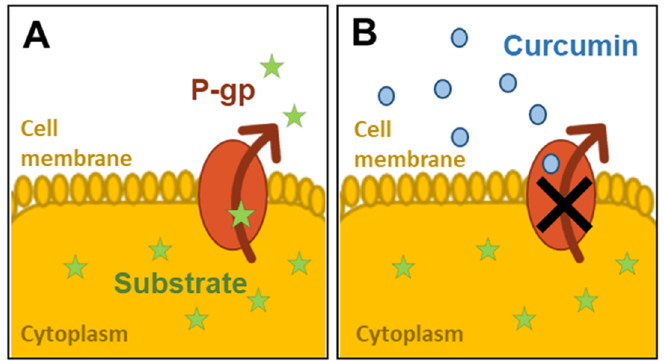
Figure 1. Inhibition of P-glycoprotein (P-gp) activity by curcumin: ( A ) the substrate is pumped out of the cell cytoplasm by P-gp; ( B ) the activity of P-gp is inhibited by the presence of curcumin molecules on the apical surface.